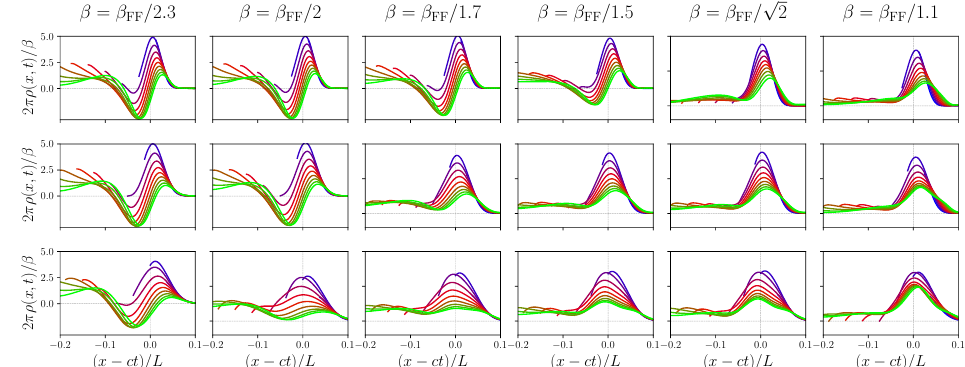
(c) Plots of the right-moving front at different times as in (b) for all the different cases in Fig. 4.6a (first / m = 12, m σ = 1 / 3, second row: A β row: A β FF 1 1 σ = 2 / 3). m 1 Figure 4.7: Profile of the propagating front in the co-moving frame at different times, for the TCSA simulations shown in Fig. 4.6a. The qualitative shape of the front and especially its width are relatively stable with time for all parameters, but the height of the initial bump tends to decrease, while the depth of the accompanying dip which is present in the KG-like cases (once it is fully developed) remains practically invariant with